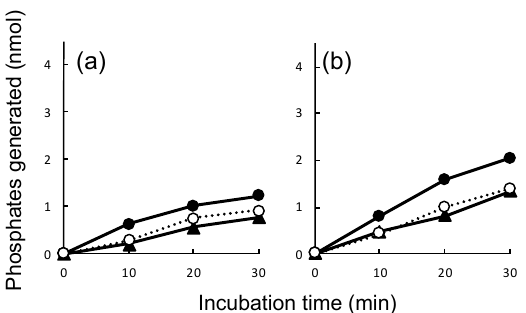
Incubation time (min) Figure 6. Double-stranded nucleic acid-dependent ATPase assays of Dicer-related helicase (DRH)-1 treated with and without small ubiquitin-like modifier (SUMO) protease. Poly-histidine (His)-SUMO-tagged DRH-1 was digested with and without SUMO protease ( a and b , respectively). The ATPase activity of approximately 500 nM of DRH-1 was measured in the absence (open circles on dotted lines) or presence of dsDNA (closed triangles) and dsRNA (closed circles) using a QuantiChrom ATPase / GTPase Assay Kit, as described in the Materials and Methods section. The reactions were performed in duplicate at 37 ◦ C for the indicated periods, and the phosphate amounts generated in the reactions were plotted.